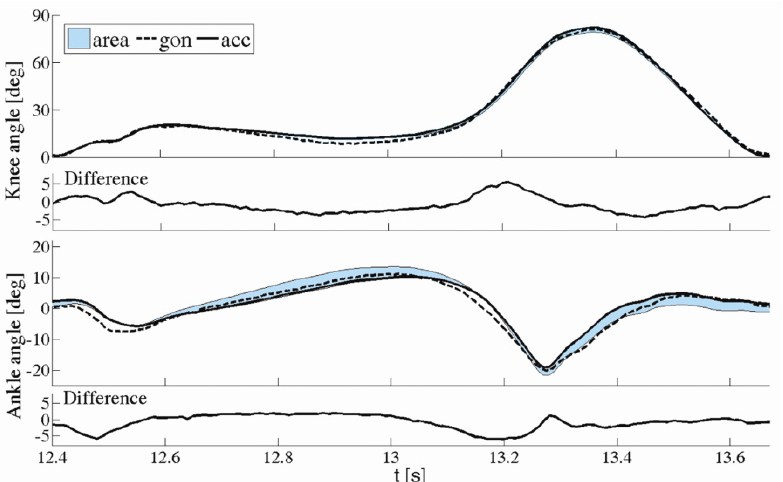
Figure 6. Knee and ankle joint angles measured with goniometers and estimated from accelerometers. Thick lines represent angles from goniometers (dashed line) and accelerometers (solid line) for optimal filter frequency. Blue areas show the range of angle values estimated from accelerometers when filtered with various frequencies in the range [ f /3, f /2]. gc gc